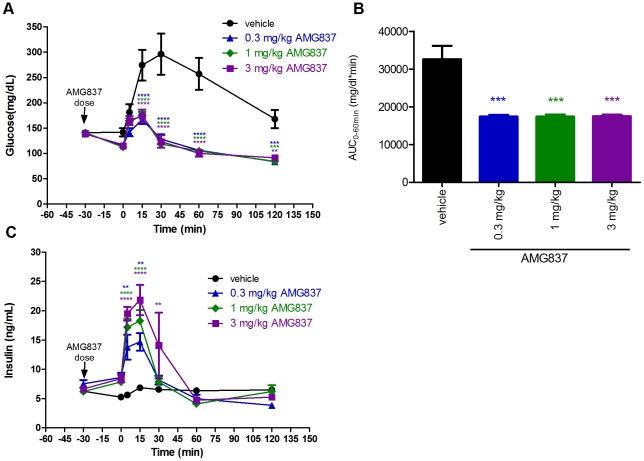
Efficacy of AMG 837 in Zucker fatty (fa/fa) rats following a single dose.8-week old Zucker fatty rats were administered a single bolus of AMG 837 (at 0.3, 1 and 3 mg/kg, n = 6/group) by oral gavage 30-minutes prior to an intraperitoneal glucose challenge at t = 0 minutes. (A) Blood glucose during the IPGTT (black circle = vehicle, blue triangle = 0.3 mg/kg AMG 837, green diamond = 1 mg/kg AMG 837 and purple square = 3 mg/kg AMG 837) (B) Glucose AUC (from −30 to 120 minutes) during the IPGTT. (C) Plasma insulin levels during the IPGTT (black circle = vehicle, blue triangle = 0.3 mg/kg AMG 837, green diamond = 1 mg/kg AMG 837 and purple square = 3 mg/kg AMG 837). Statistical significance compared to vehicle treated animals is denoted by * (p<0.5), ** (p<0.01), *** (p<0.001) and **** (p<0.001) as determined by one-way or two-way ANOVA and colors match the corresponding groups in the figure legend.